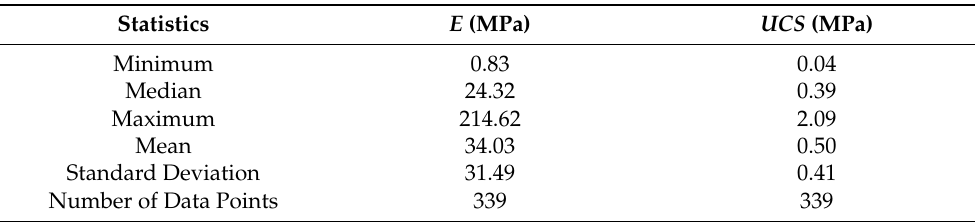
Table 4. First order statistics of response variables Elastic Modulus ( E ) and Unconfined Compression Strength ( UCS ).